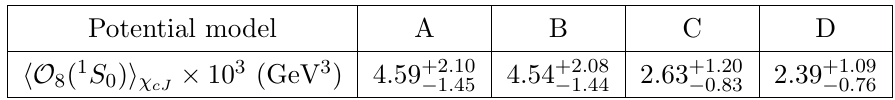
Table 9 . Results for the matrix element h (cid:31) cJ (1 P ) jO 8 ( 1 S 0 ) j (cid:31) cJ (1 P ) i at the scale (cid:22) (cid:3) = 1 GeV, indicated with hO 8 ( 1 S 0 ) i (cid:31) for short. The wavefunctions at the origin have been computed within cJ the potential models of section